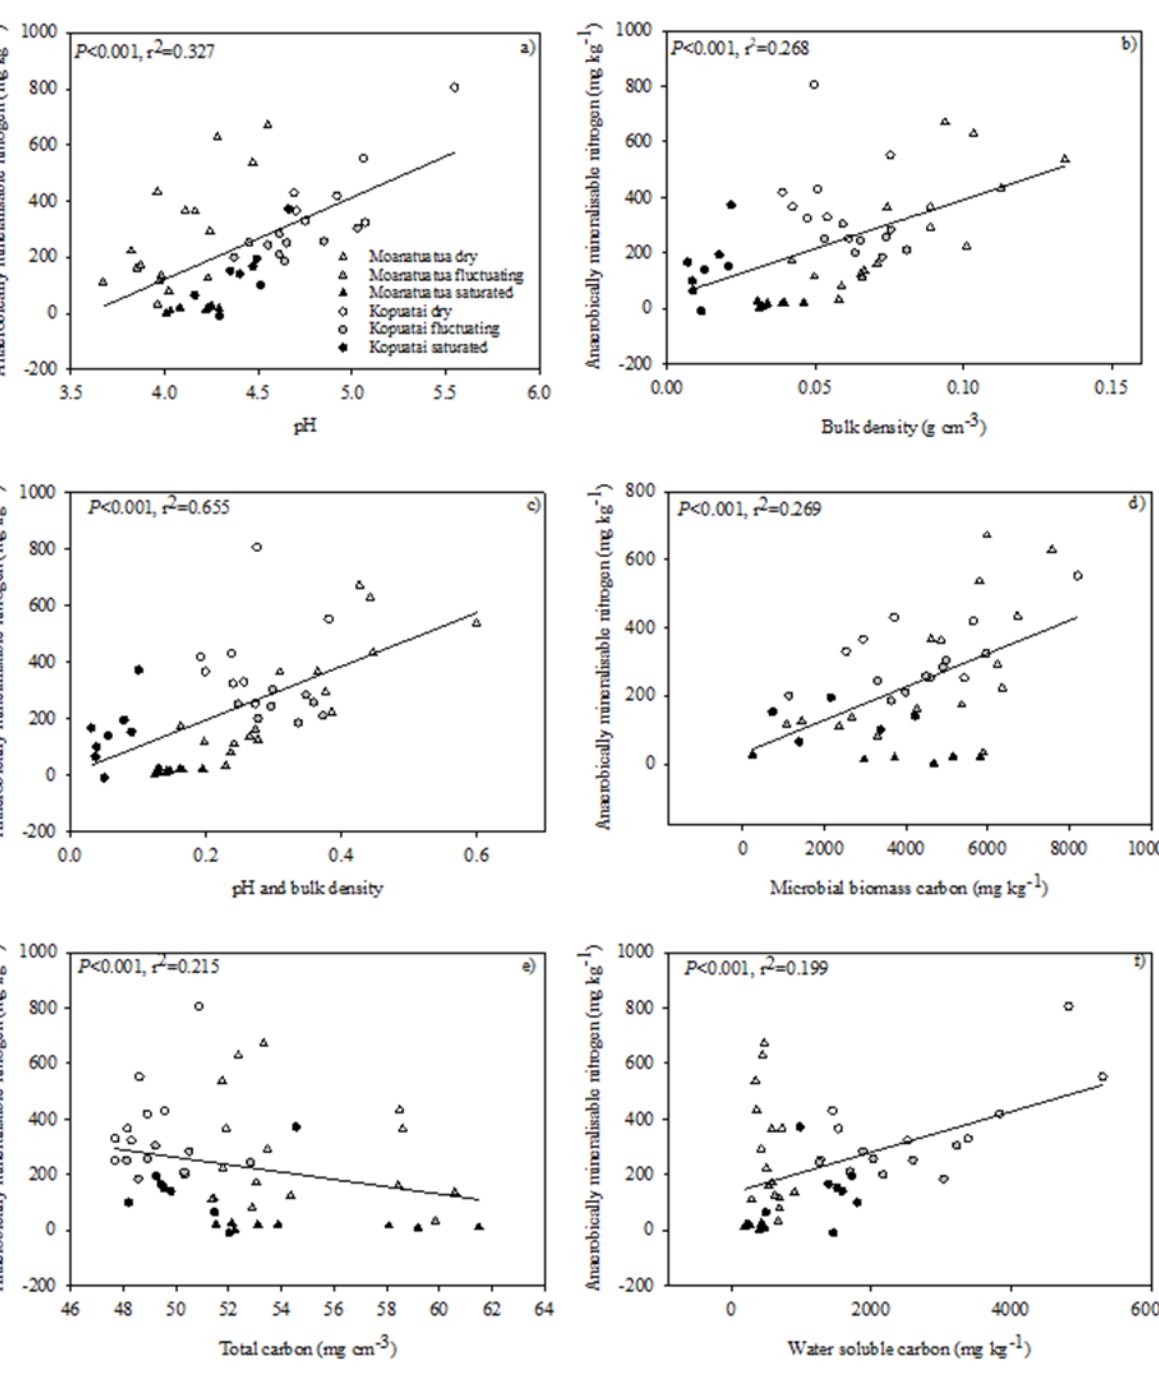
Figure 5. Linear regression analysis of anaerobically mineralisable nitrogen and a) pH, b) bulk density, c) pH and bulk density, d) microbial biomass carbon, e) total carbon and f) water-soluble carbon, at Moanatuatua (degraded peatland; triangles) and Kopuatai (intact peatland; circles). enhancing enzyme activities (Pinsonneault et al